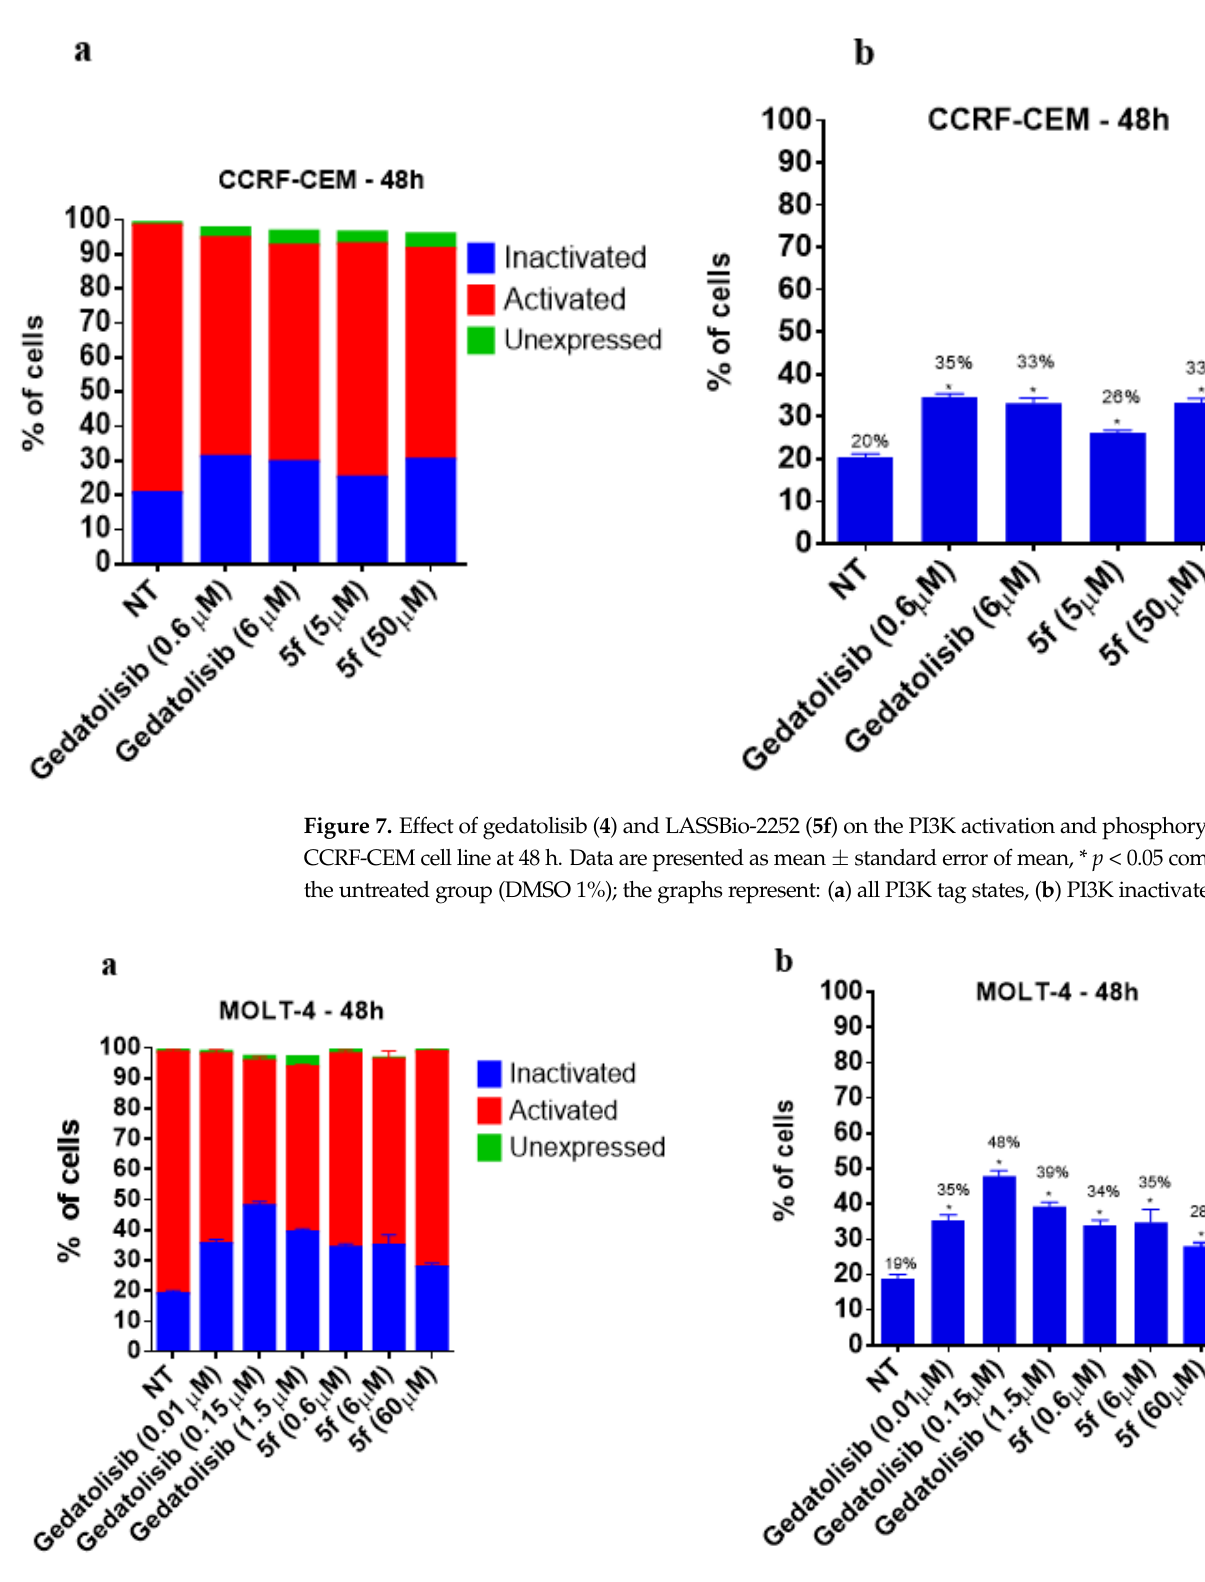
Figure 8. Effect of gedatolisib ( 4 ) and LASSBio-2252 ( 5f ) on the PI3K activation and phosphorylation in MOLT-4 cell line at 48 h. Data are presented as mean ± standard error of mean, * p < 0.05 compared to the untreated group (DMSO 1%); the graphs represent: ( a ) all PI3K tag states, ( b ) PI3K inactivated.